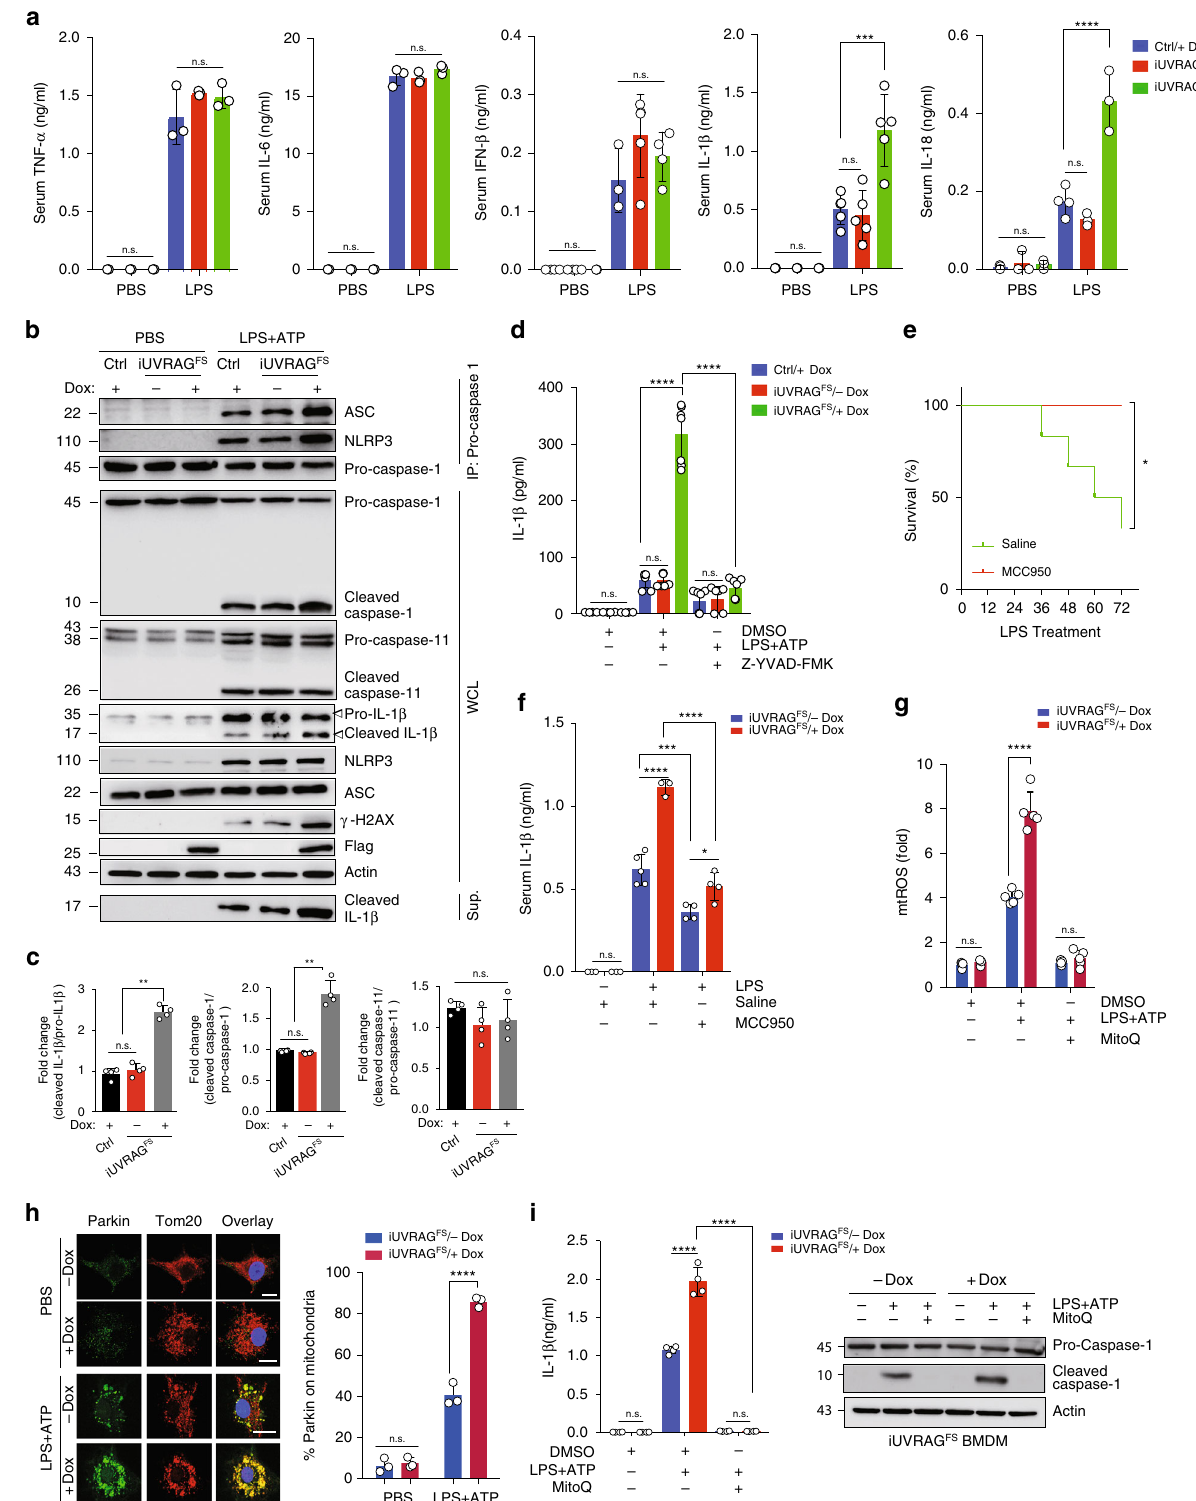
Fig. 4j – l). Although in fl ammatory cytokines IL-6 and TNF- α were unaffected, colonic IL-1 β was signi fi cantly lower after